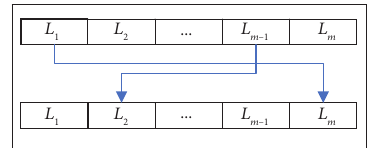
Figure 4: Changing task execution resources.